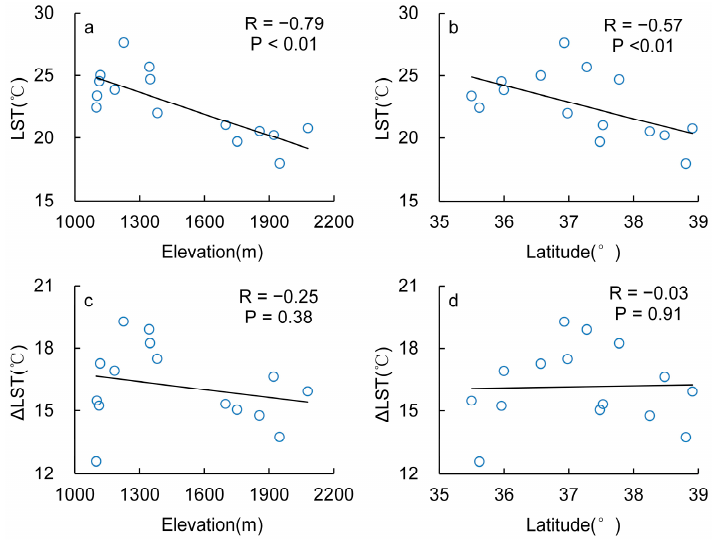
Figure 3. Scatterplots and correlation coefficient R values between LST and elevation ( a ); LST and latitude ( b ); ∆ LST and elevation ( c ); and ∆ LST and latitude ( d ).